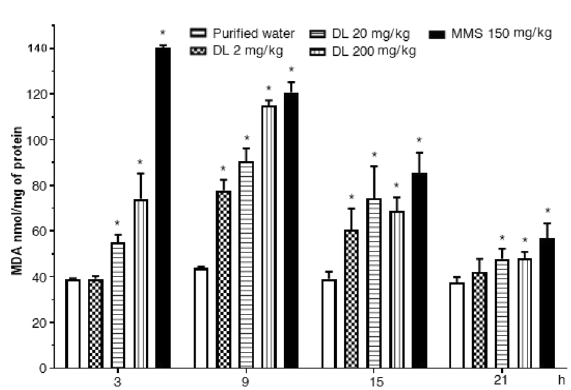
Figure 3. Mouse brain ( A ) and liver cells ( B ) treated with duloxetine (DL) and methyl metanesulfonate (MMS). Comet assay added or not with the enzyme formamido pyrimidine-DNA glycosilase (FPG). Results correspond to the effect of a single administration of each compounds evaluated at 9 h post-administration. Each bar correspons to the mean ± SEM obtained in 100 nucleoids per mouse, 5 mice per group. *Statistically significant difference with respect to the value without FPG. ANOVA and post hoc Student–Newman–Keuls tests ( p ≤ 0.05).